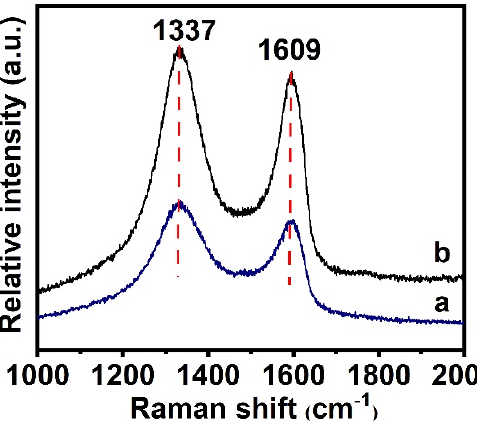
Figure 6. Raman spectra of GO (a) and QDs/polymer/GO fluorescence nanohybrid (b).